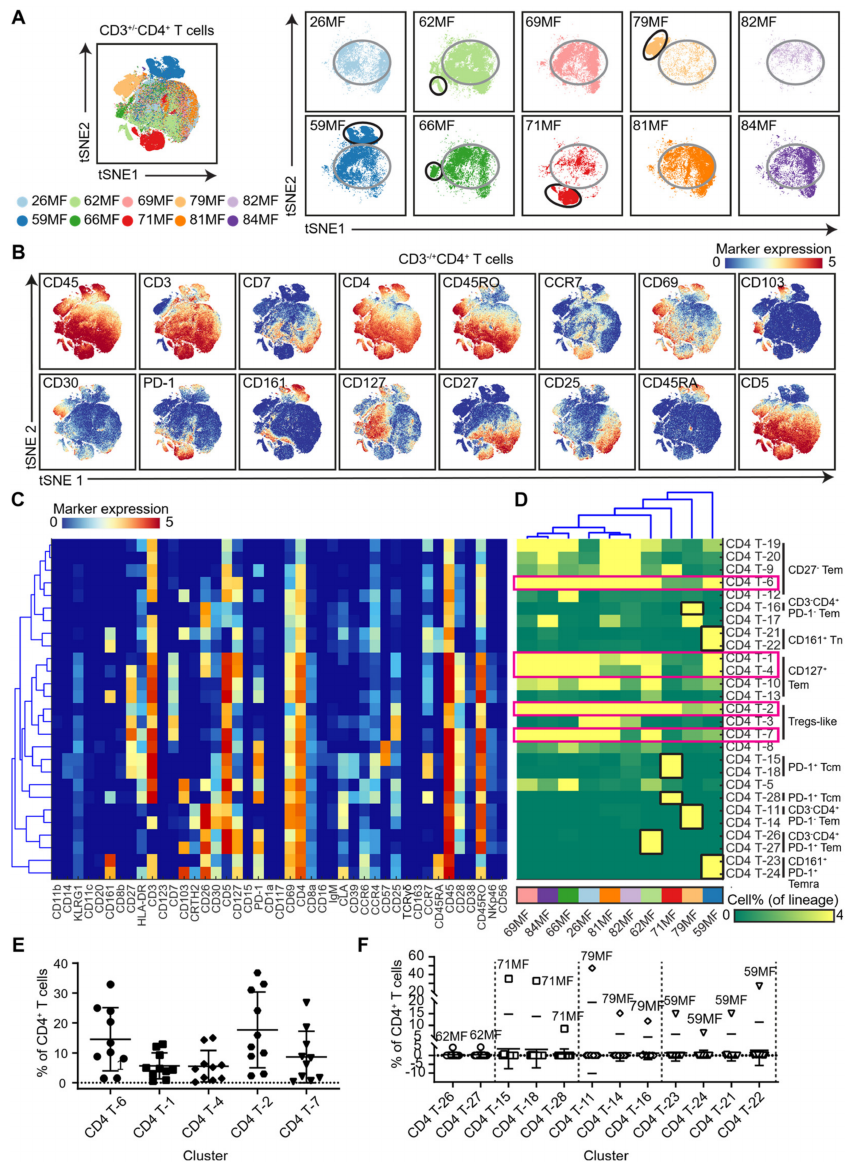
Figure 3. Identification of phenotypically distinct clusters in the CD3 +/ − CD4 + T-cell compartments across the MF samples. ( A ) A collective t-SNE was performed on CD4 + T cells (CD3 + CD4 + T cells and CD3 − CD4 + T cells) and stratified for samples ( n = 10). In total, 2.3 × 10 5 CD4 + T cells were analyzed in the plots. The large encircled cluster of cells (encircled in gray) harbored cells exhibiting a similar phenotype in all patients. The smaller cell clusters encircled in black were patient-unique and likely contained the abnormal cell populations in these patients. ( B ) Relative expression levels of the indicated immune markers. Colors represent different levels of marker expression. ( C ) Heatmap showing the median of the marker expression values for the clusters identified and hierarchical clustering thereof. ( D ) Heatmap showing the corresponding cell frequencies of identified clusters of total CD4 + T cells in each sample. Colors represent different MF samples as indicated below the heatmap. The dendrogram shows the hierarchical clustering of the samples. The clusters of CD4 + T cells highlighted by pink boxes were shared by the majority of the MF patients. The clusters of cells highlighted by black boxes were unique for the individual patients. ( E ) Quantification of the shared CD4 + T-cell cluster frequencies among the samples in ( C ). Cluster IDs corresponded to the ones in ( C ). ( F ) Quantification of the patient-unique CD4 + T-cell cluster frequencies among the samples in ( C ). Cluster IDs corresponded to the ones in ( C